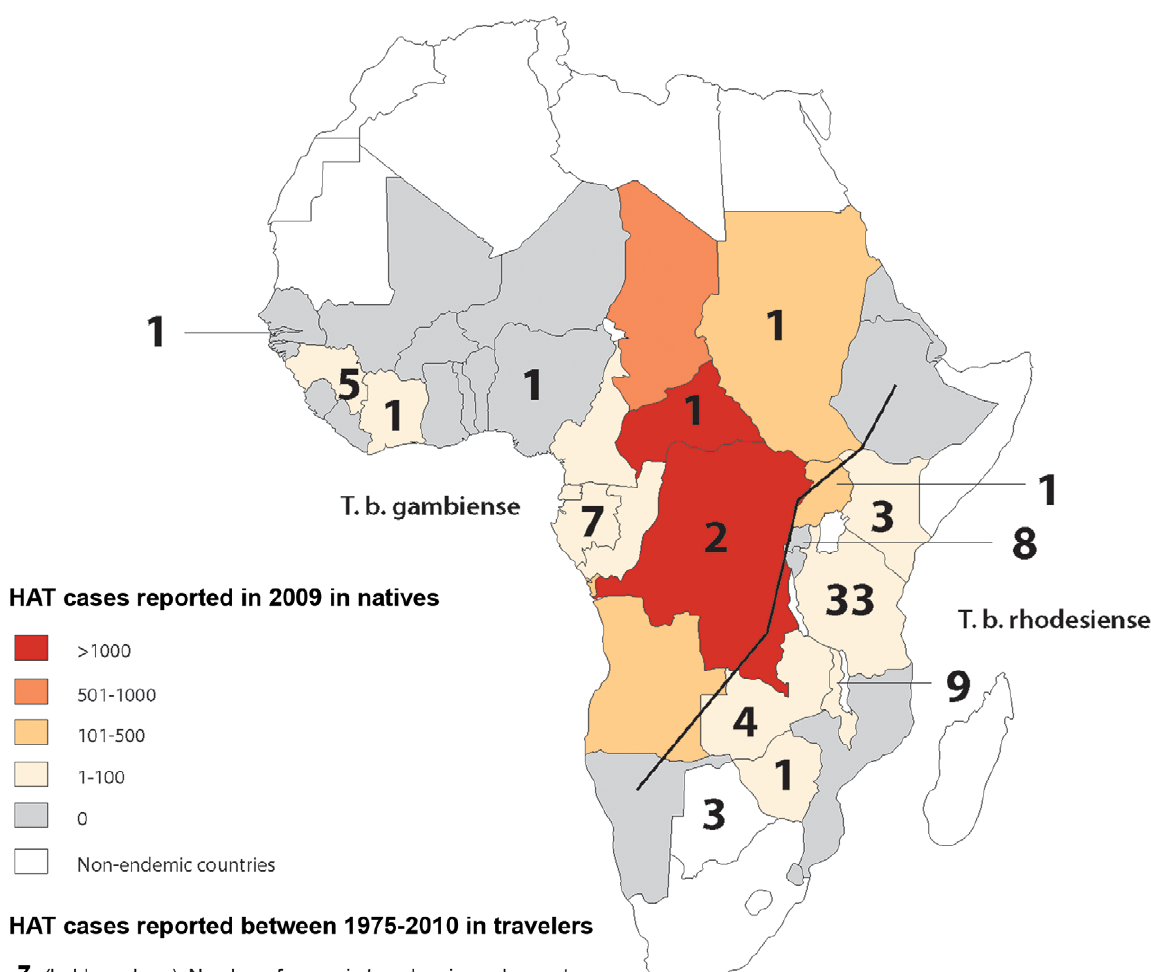
Figure 1. HAT in endemic and non-endemic populations (traveler). In 14 patients, more than one country was estimated to be country of infection: Kenya or Tanzania: 7; Cameroon or Congo: 2; Nigeria or Gabon: 1; Zambia or Botswana: 1, Zambia, Zimbabwe or Tanzania: 1; Namibia, Mozambique or Malawi: 1, East Africa: 1 (these patients are not counted in the figure). The black line divides the endemic regions of T.b. gambiense and T.b. rhodesiense HAT. Modified data from Simarro P. et al. 2011.